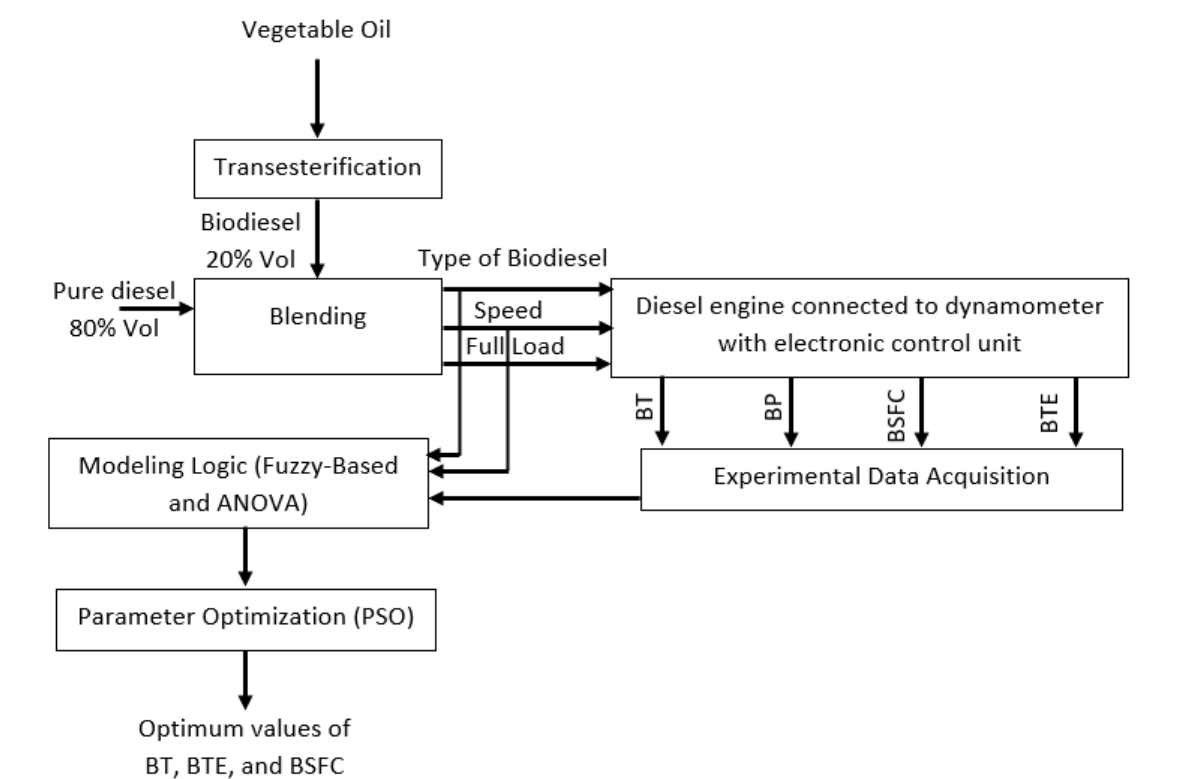
Figure 3. A schematic diagram of the experimental approach integrated with an optimization pro- cess.